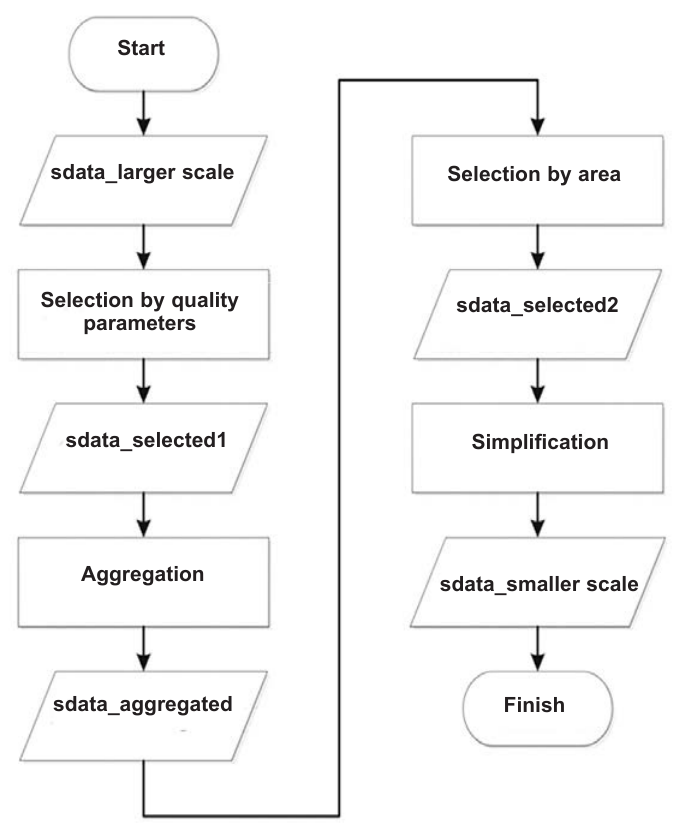
Fig. 1. The conception process of the generalization of land